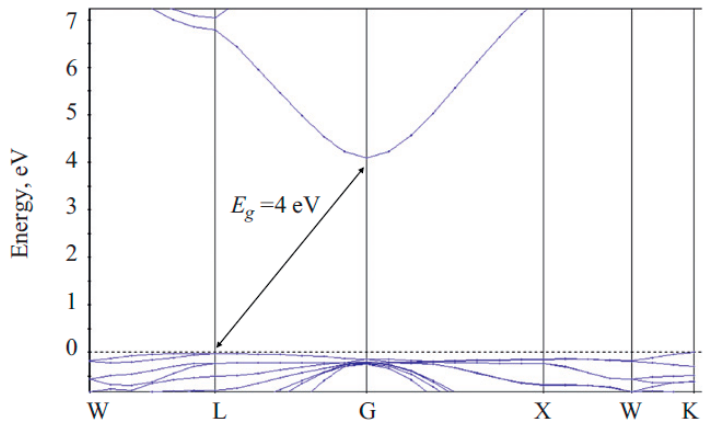
Figure 3. Calculated band structure of ZnGa 2 O 4 [51] (with copyright permission from Elsevier,